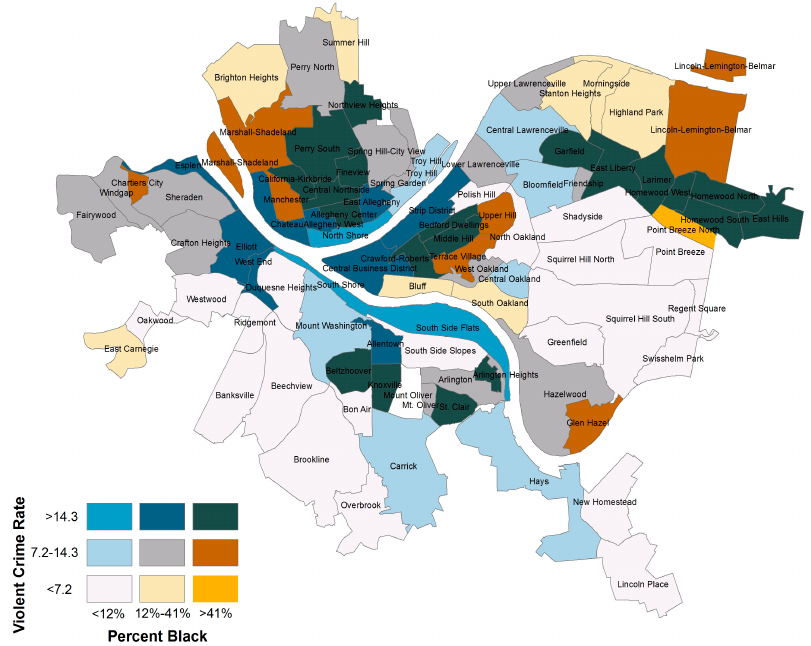
Figure 4. Map of violent crime rate by percent black across Pittsburgh neighborhoods.